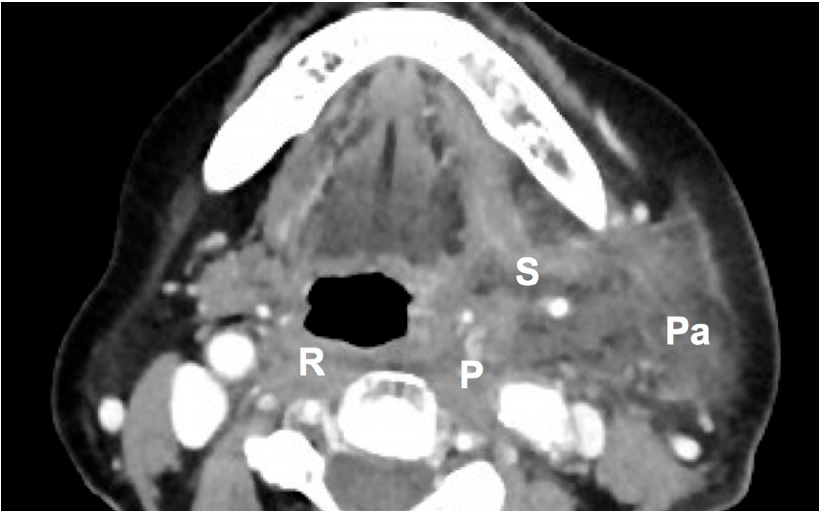
Figure 2. The axial view of CT from a patient with multiple deep neck spaces involved. There were abscess formations in retropharyngeal space, parapharyngneal space, submandibular space, and parotid space. (R: retropharyngeal space; P: parapharyngeal space; S: submandibular space; Pa: parotid space).